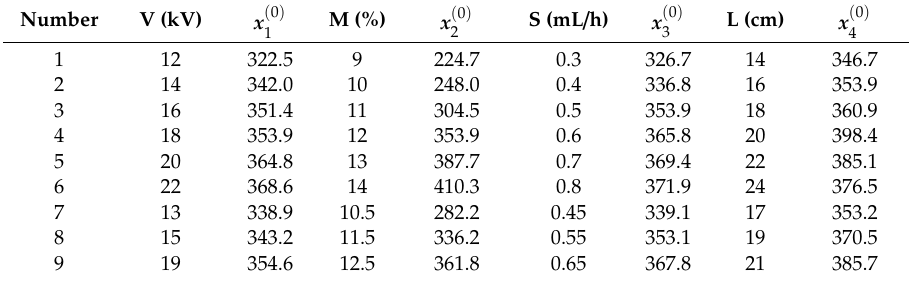
Table 1. Experimental data sheet for the e ff ect of individual factors on fiber diameter. L: the distance between the nozzle and the collecting plate; M: the mass fraction of polyacrylonitrile (PAN) solution; S: the flow rate of the solution at the nozzle; V: the loading voltage at the nozzle; x value of nanofiber